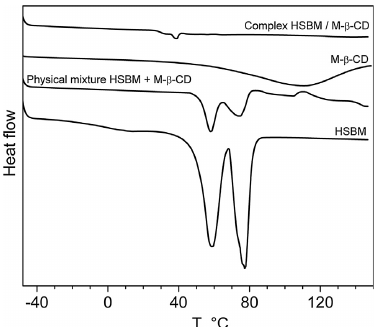
Figure 17. DSC thermograms of hydrogenated soybean monomer, methyl- β -cyclodextrin, their physical mixture, and inclusion complex. Reprinted from [32]. Copyright (2018), with permission from Elsevier.